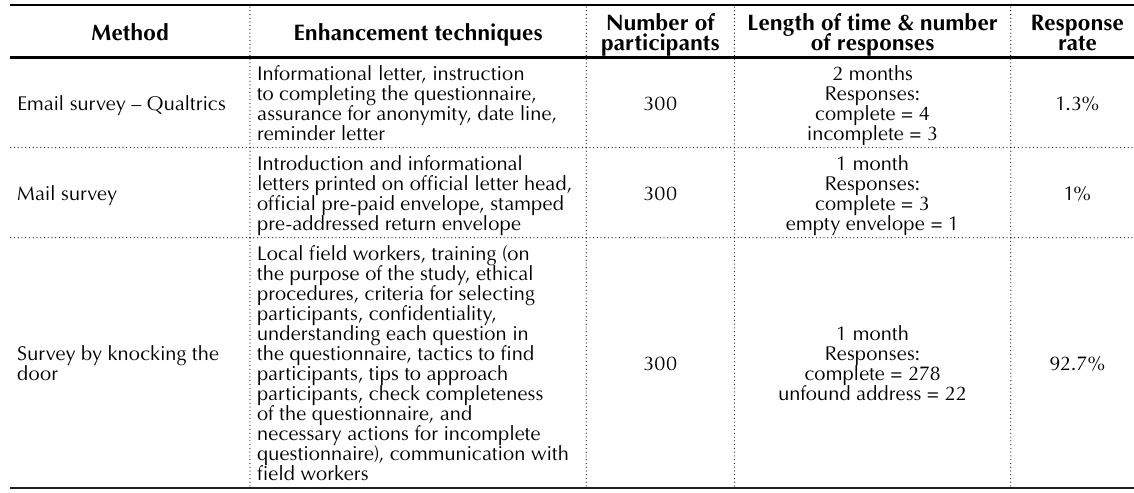
Table 1. Survey methods and the response